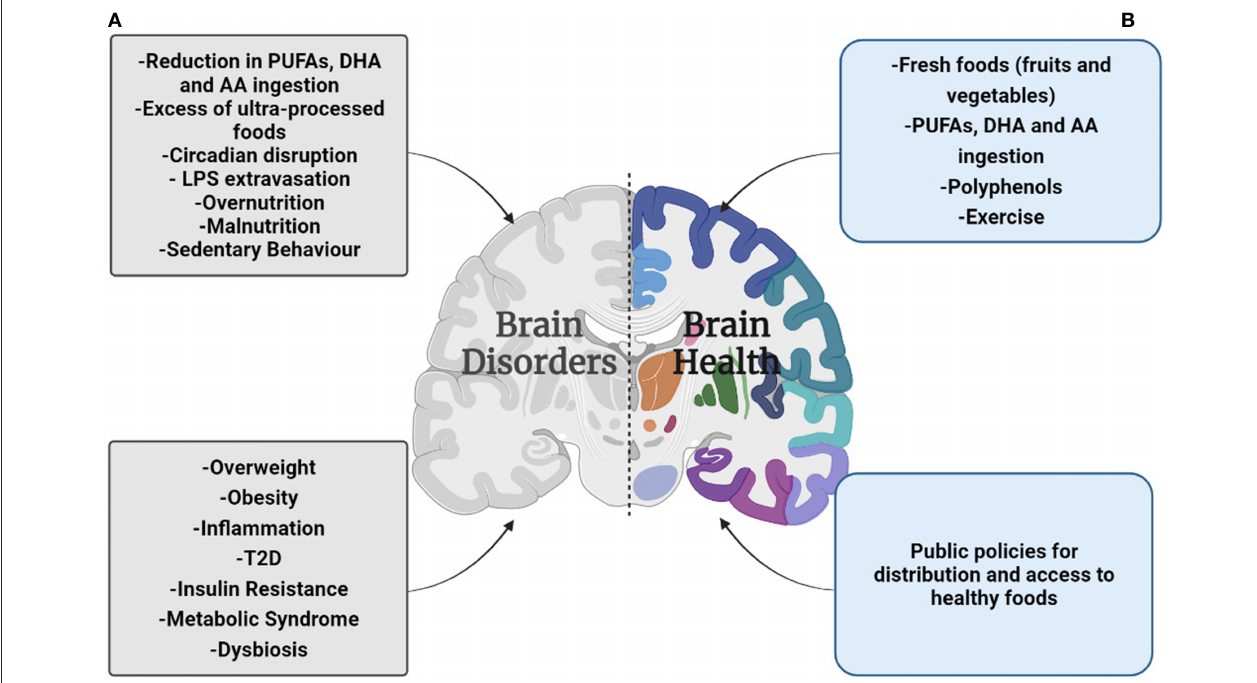
FIGURE 1 | Summary overview of the malnutrition effects on brain health during the COVID-19 pandemic. (A) The preponderance by the UPF’s ingestion, circadian disruption, and a sedentary lifestyle will facility the gain of body weight, leading to suffering overweight/obesity, and in a worst-case scenario suffer metabolic syndrome and T2D. Moreover, overweight/obesity increases the risk of low-grade chronic inflammation; the pro-inflammatory cytokines hinder the blood-brain barrier function deteriorating brain health. Additionally, the higher rate of unemployment and the rising price of food have reduced the affordability of fresh products, and protein based-products, resulting in a poor quality diet. This condition is a factor that reduces brain integrity that leads to suffering brain disorders. (B) The public services focused to facilitate the practice of physical exercise during the lockdown, and better distribution and access to healthy food will strengthen the brain health and reduce the risk to suffer brain